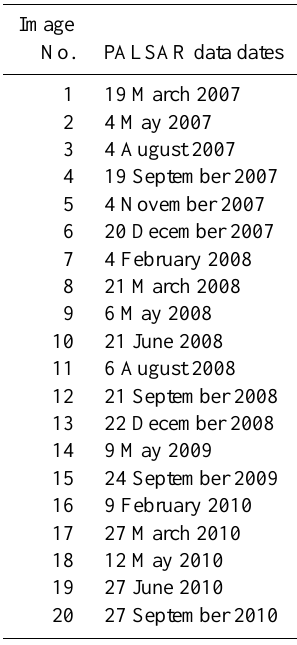
Table 1. PALSAR images used in this